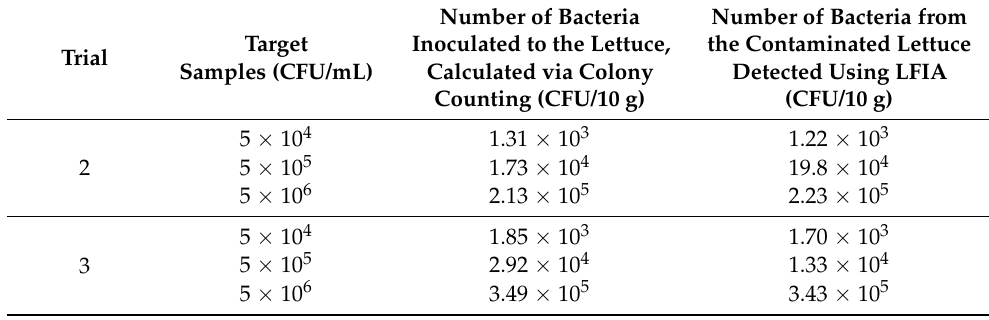
Number of Bacteria from the Contaminated